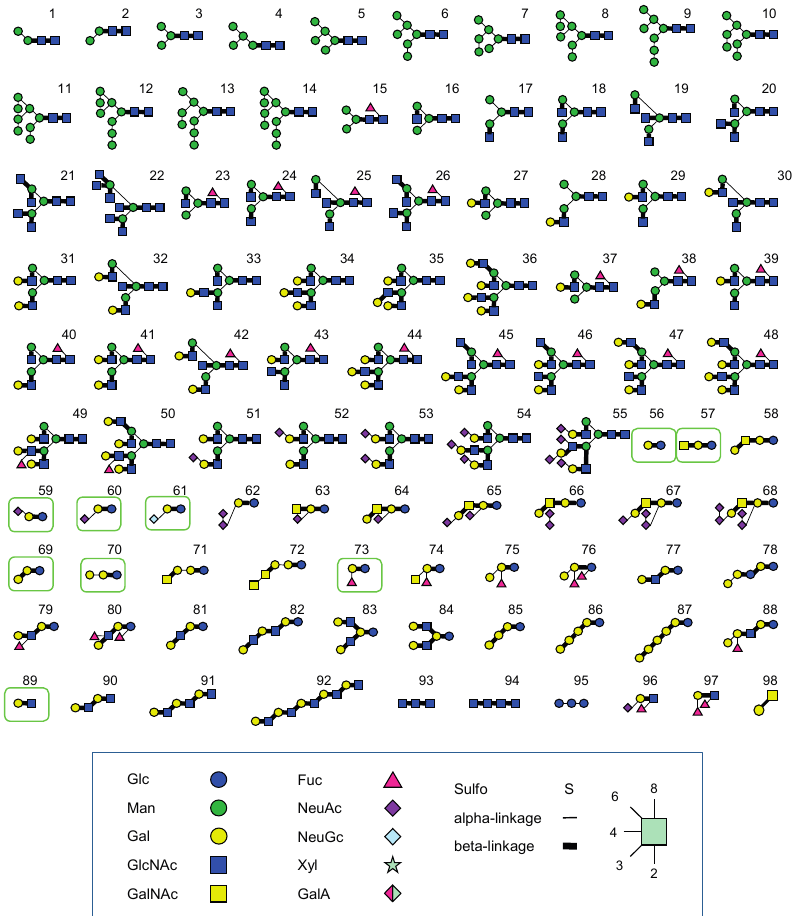
Figure 1. A list of pyridylaminated (PA) oligosaccharides routinely used for FAC. Nine oligosaccharides which are related to one another are described in the context of “One Parameter” function in the L f DB (see text and Figure 2). Note that reducing terminal end of PA-saccharide is opened as a result of monoamine coupling with